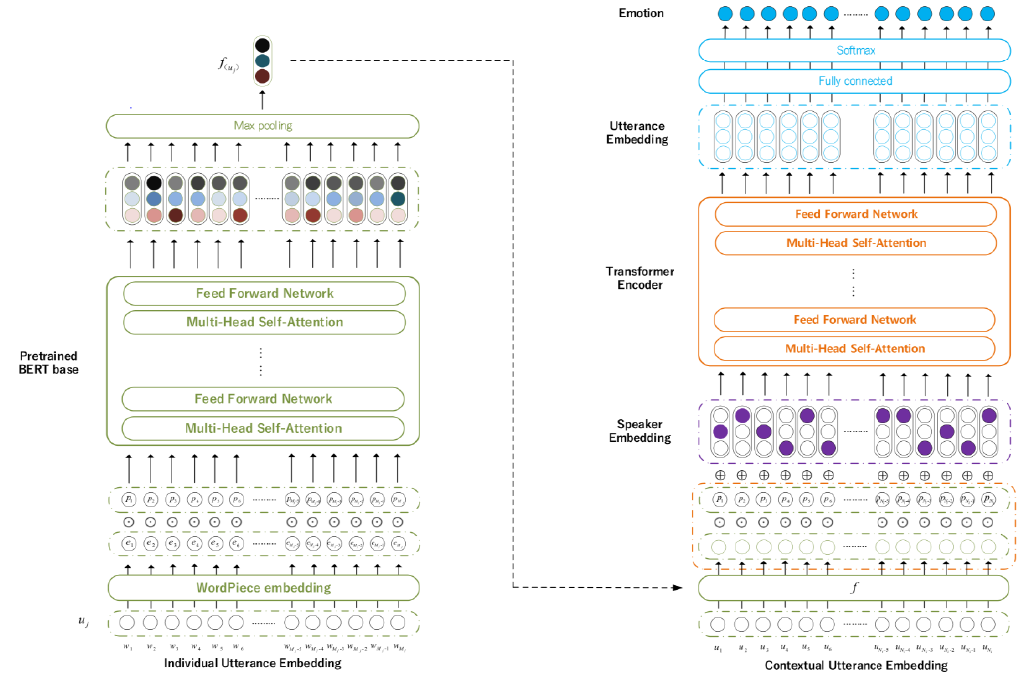
Figure 3. The architecture of our proposed HiTransformer-s. By removing the “Speaker Embedding” layer, we attain the HiTransformer.